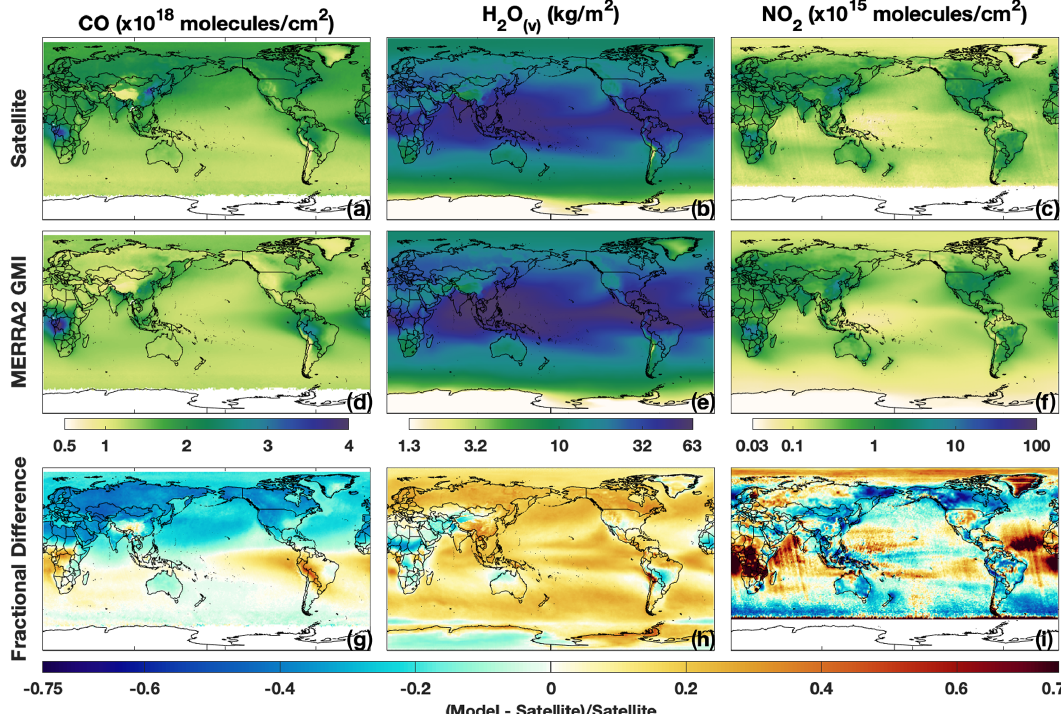
Figure 3. Same as Fig. 2 except for JJA (June–August).